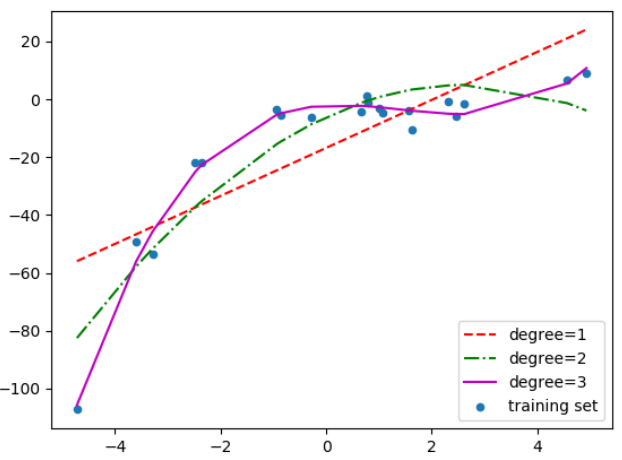
Figure 6. Comparison of the accuracy of the approximation of the function 𝑓(𝑥) depending on the degree of the approximating polynomial.